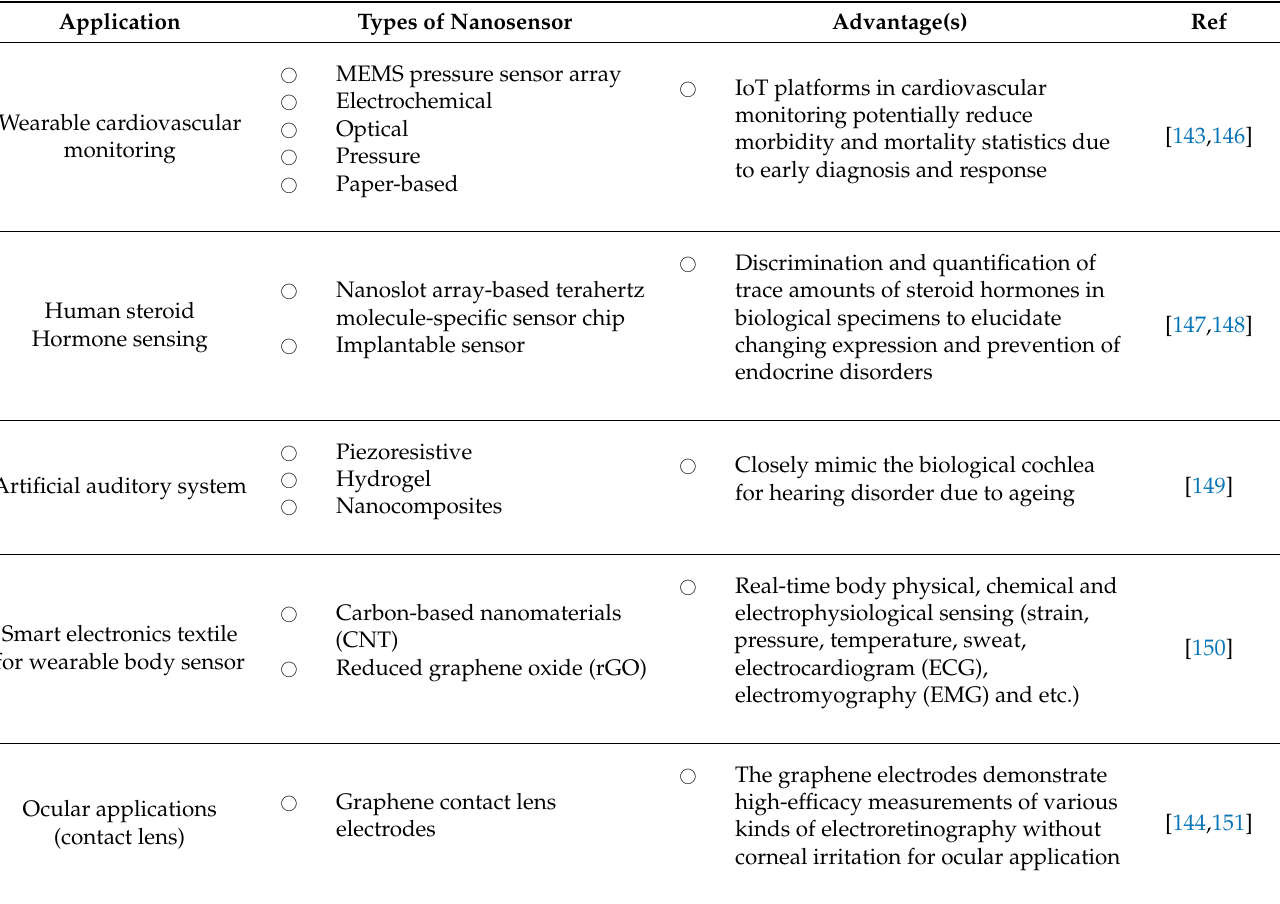
Table 3. Examples of nanomaterials-based nanosensors in wearable devices and